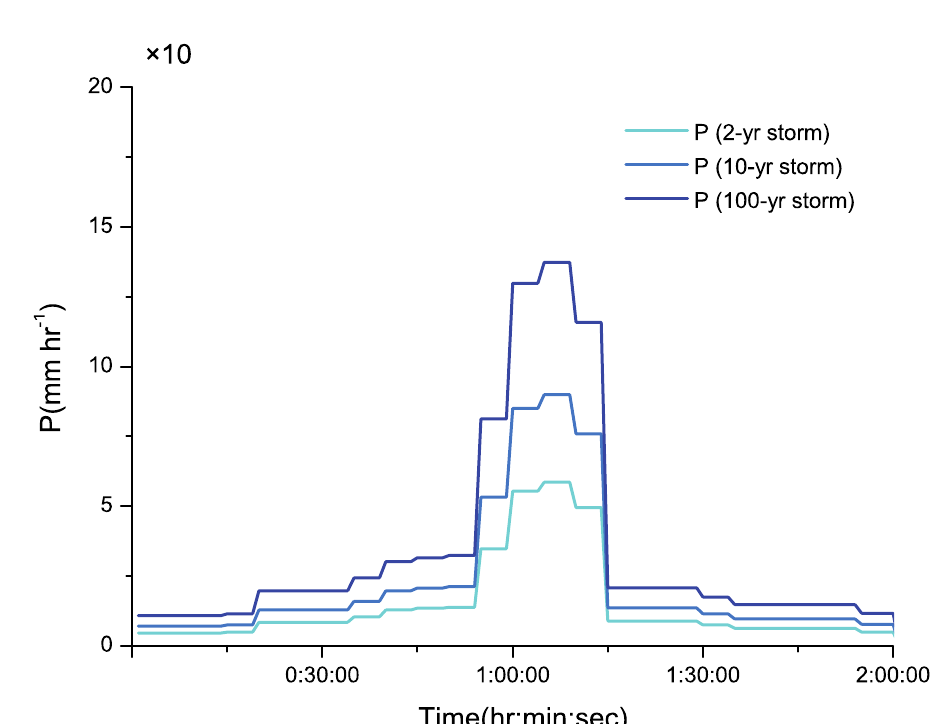
Figure 4. Two hours Precipitation of 2-yr, 10-yr and 100-yr Storms. 270